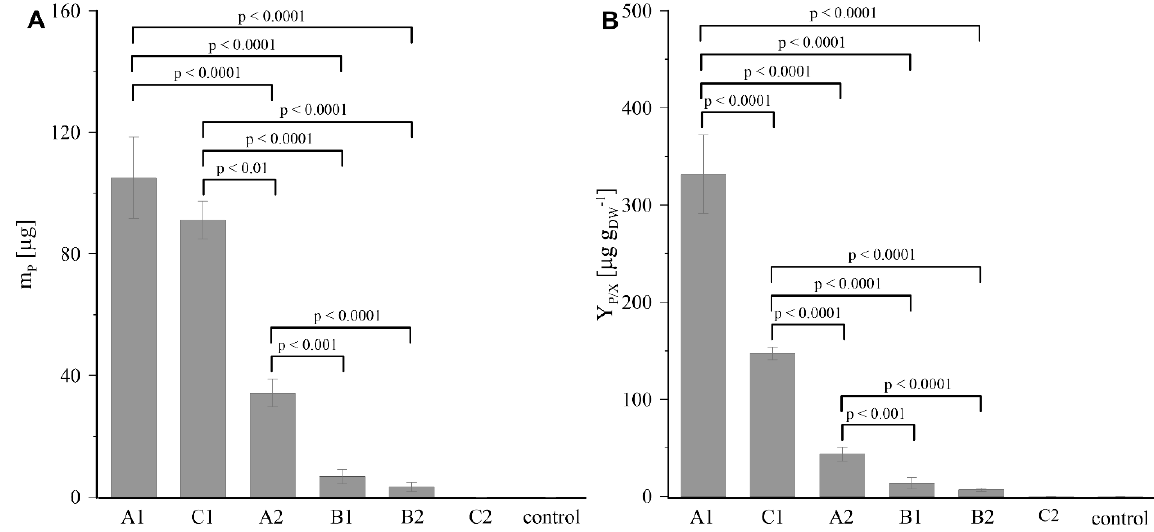
Figure 7. Values of m P ( A ) and Y P/X ( B ) obtained for cultures of R. graeca hairy roots supported with various MTMS-based materials and for the control culture: (A1) disintegrated mesoporous xerogel, (B1) disintegrated macroporous xerogel, (C1) aggregated precipitate of MTMS, (A2) PP-reinforced mesoporous xerogel, (B2) PP-reinforced microporous xerogel, (C2) PP fibers with a deposited precipitate of MTMS. The p values over brackets were determined according to the ANOVA test.